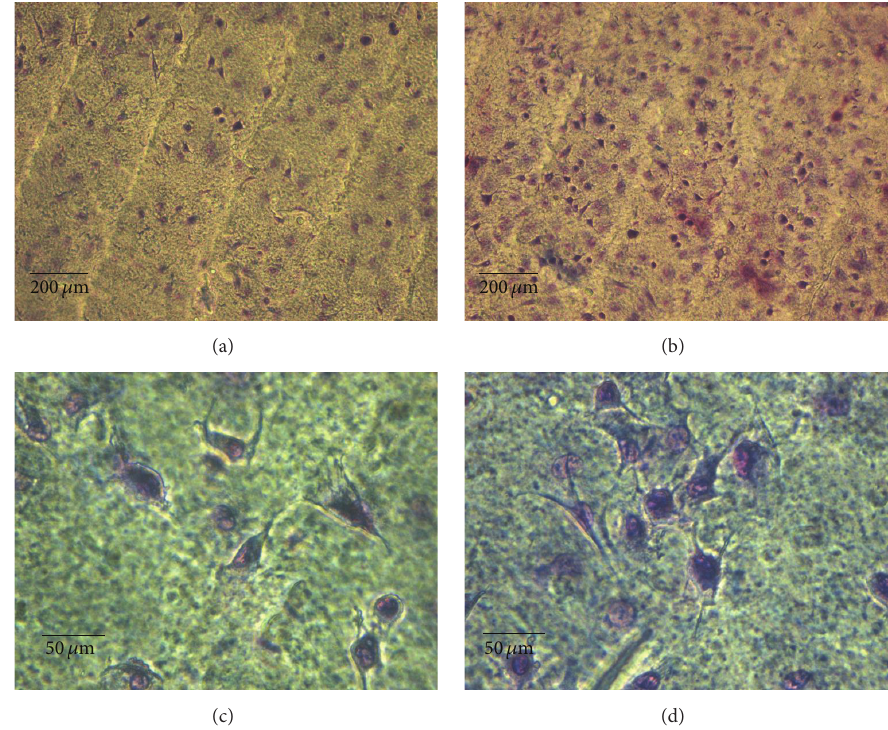
Figure 5: BMPC attachment (2h at 37 ∘ C) to 𝐶0 ((a) and (c), Obj. × 10.) and 𝐶2 (20 𝜇 g/mL per cm 2 VOAsc) membranes ((b) and (d), Obj. 40x). Giemsa staining. Morphological images of BMPC are also representatives of the results for 𝐶1 and 𝐶3